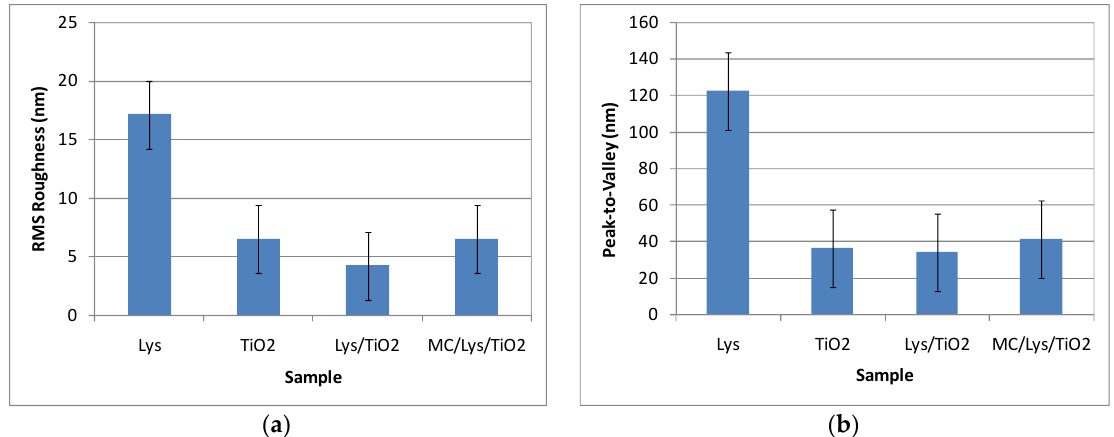
Figure 7. Corrugation characteristics of all scanned systems: RMS roughness ( a ) and peak-to-valley ( b ). Evaluated from AFM images measured after 48 h.